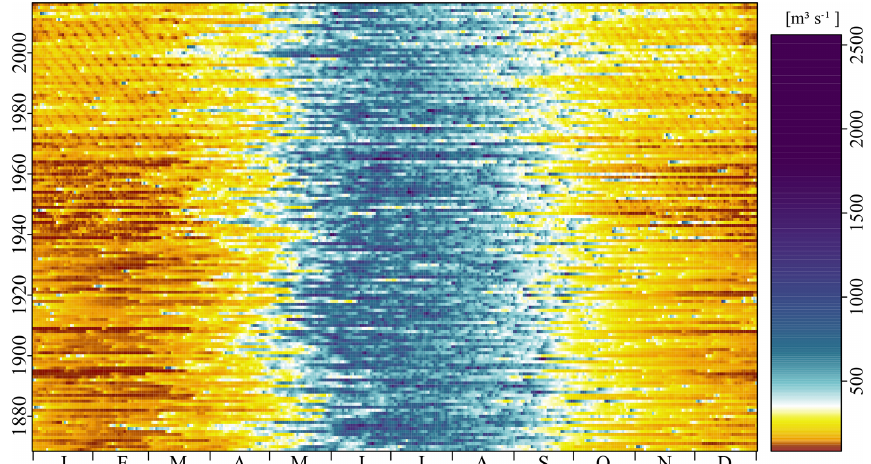
Figure F1. Raster hydrograph for gauge Wasserburg. In recent decades, hydropeaking (weekly pattern) due to the operation of high-head storage hydropower stations imprinted. Time frame displayed: